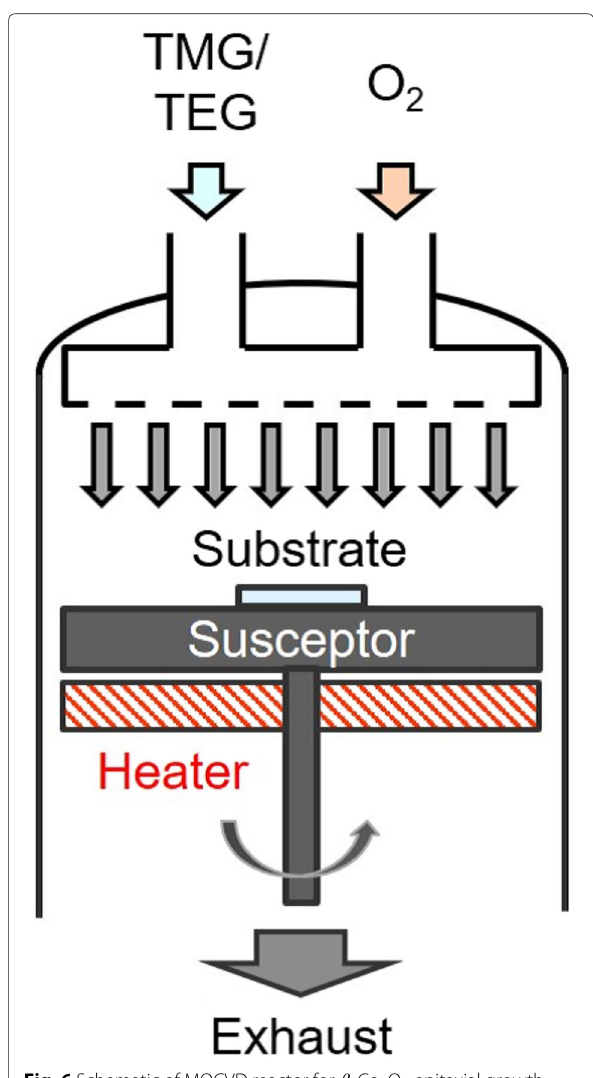
Fig. 6 Schematic of MOCVD reactor for β -Ga 2 O 3 epitaxial